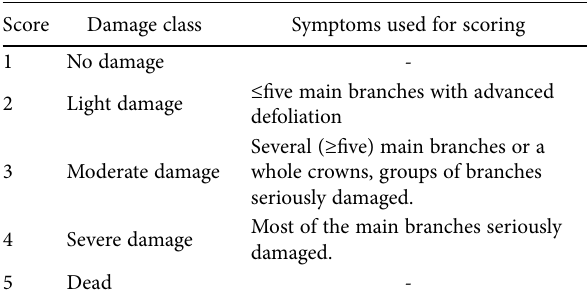
Table 2. Disease severity scores used for assessments in pine